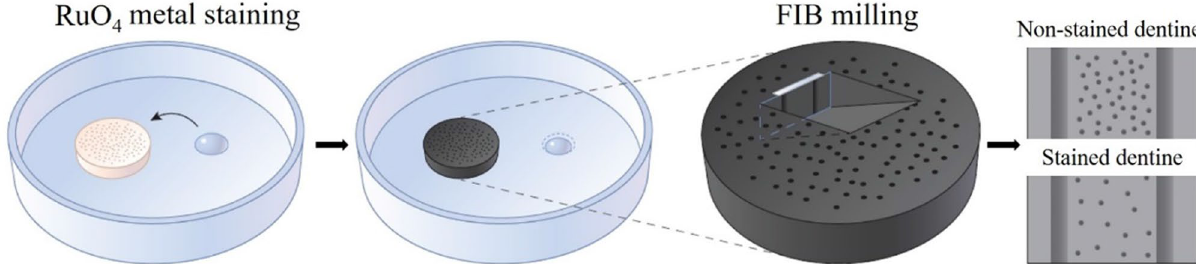
Figure 1. Experimental procedure for the protection of collagen fibers in FIB milling: the dentine disk was exposed to RuO 4 vapor, followed by FIB filling. Low porosity is achieved due to the reduction of collagen